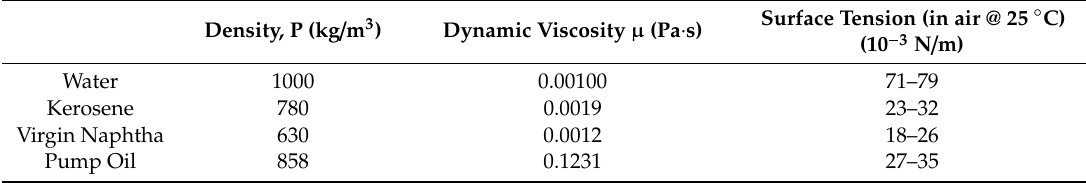
Table 1. Density ( ρ ), dynamic viscosity ( µ ), and surface tension of selected